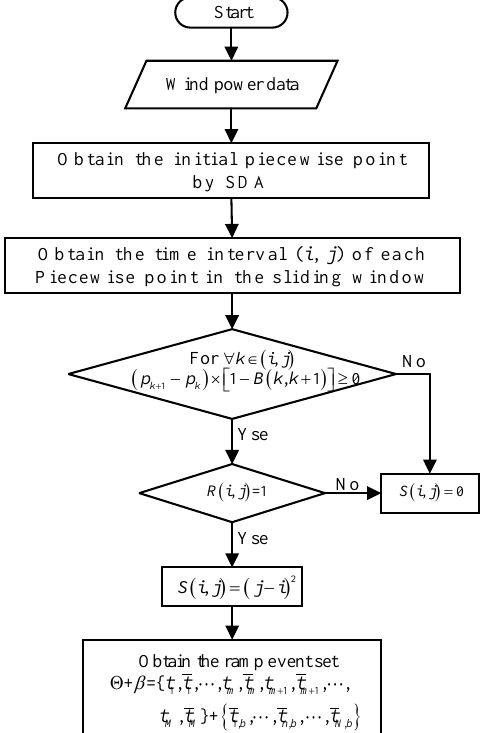
Figure 3. Flowchart of the Optimized Swinging Door Algorithm (OpSDA).